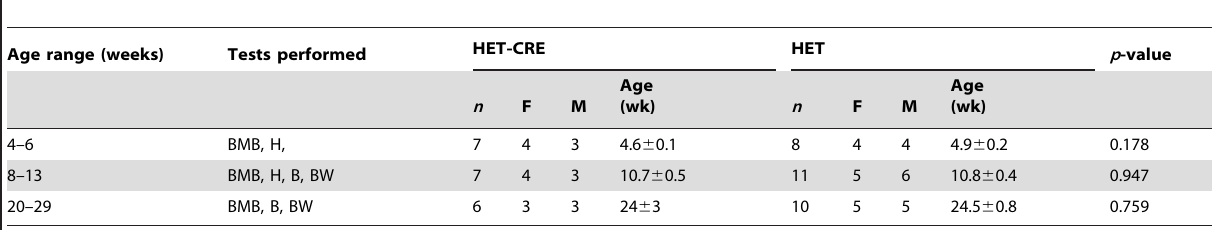
Table 1. Characteristics of the mouse groups and tests performed.